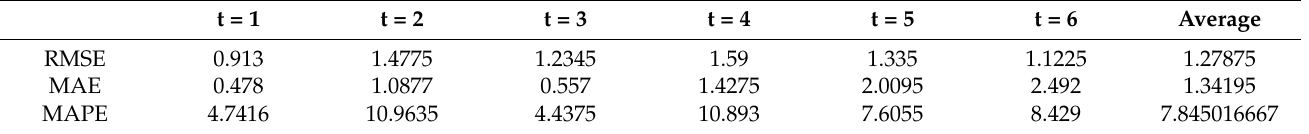
Table 10. Performance results of different univariate hybrid WSP models for South Plains TX region.